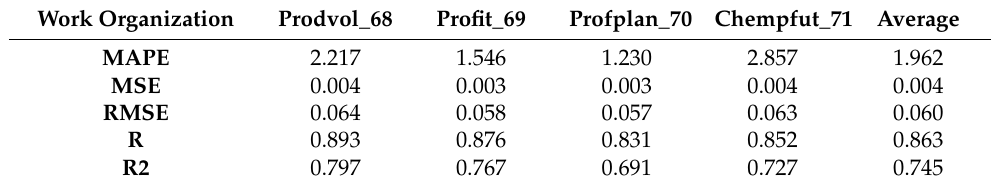
Table 6. Testing results for the effect of work organization on firm performance.